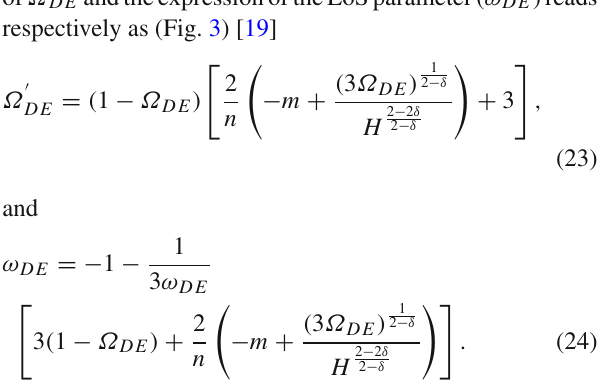
), and da attains a minima. da